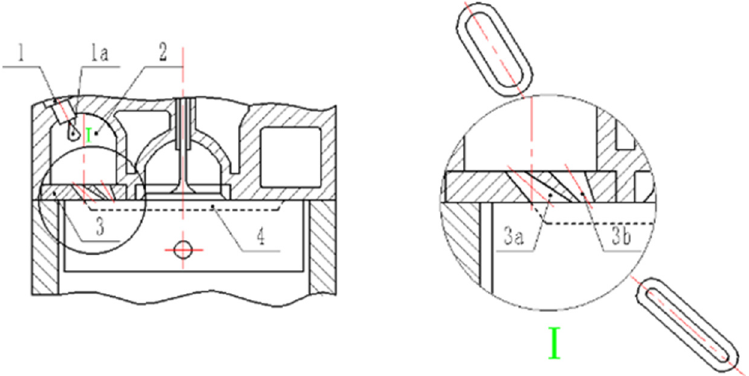
Figure 1. Sketch of a swirl chamber with variable cross-section multi-channel structures. Note: (1) nozzle, (1a) fuel beam, (2) swirl chamber, (3) insert, (3a) connecting channel 1, (3b) connecting channel 2, (4) main combustion region.